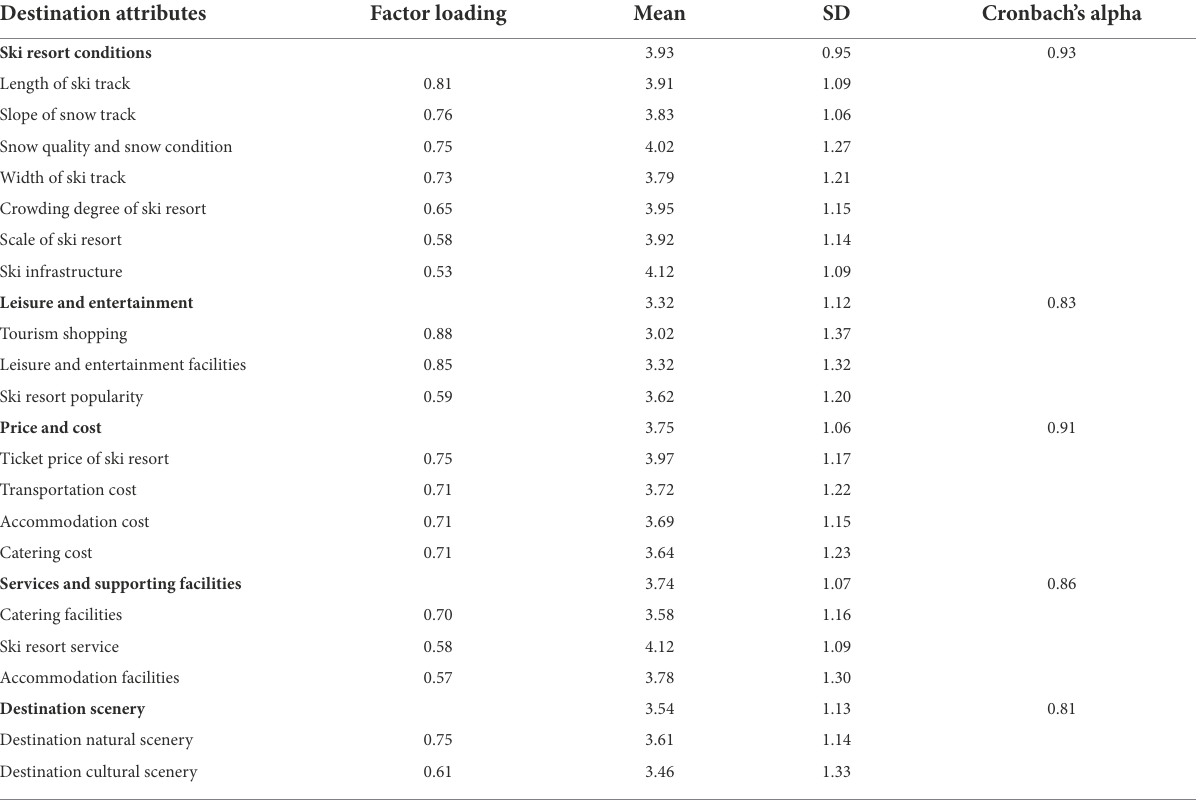
TABLE 3 Factor loading of destination